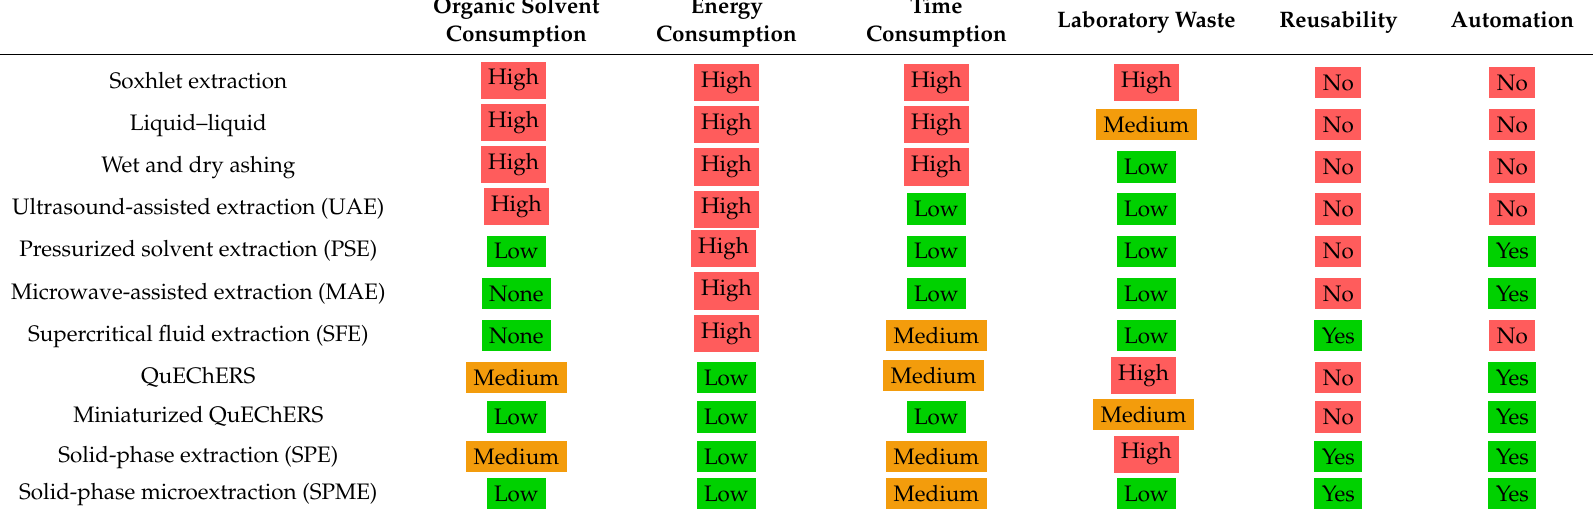
Table 2. Di ff erent sample preparation techniques are compared by relative greenness factors. Colors indicate the level of compliance to the GAC principles, red: low, orange: medium, green: